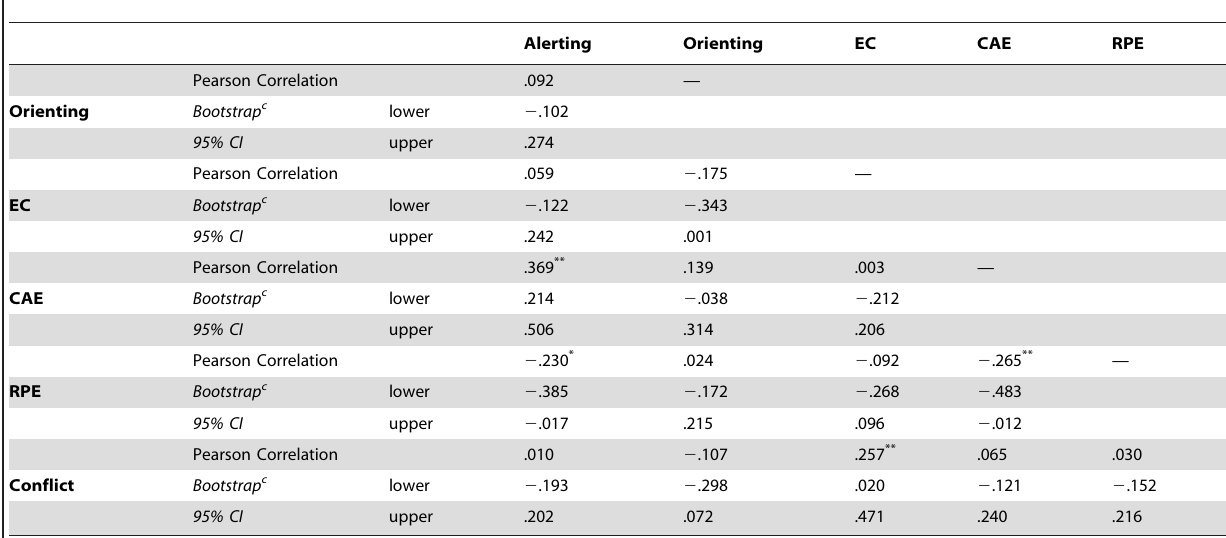
Table 1. Correlations between the related factors in Experiment